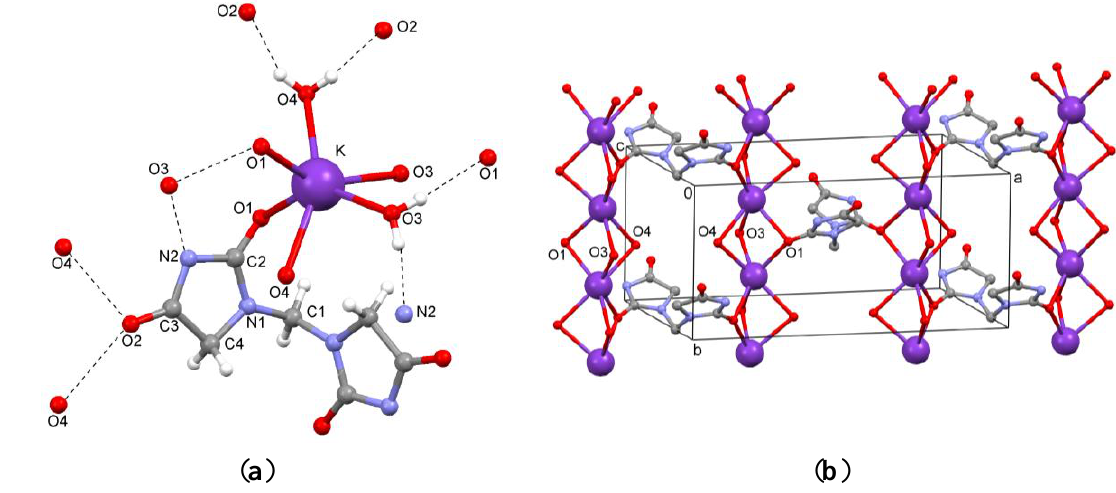
Figure 6. ( a ) Coordination of the ion pair; ( b ) Packing of the dipotassium salt 3b .